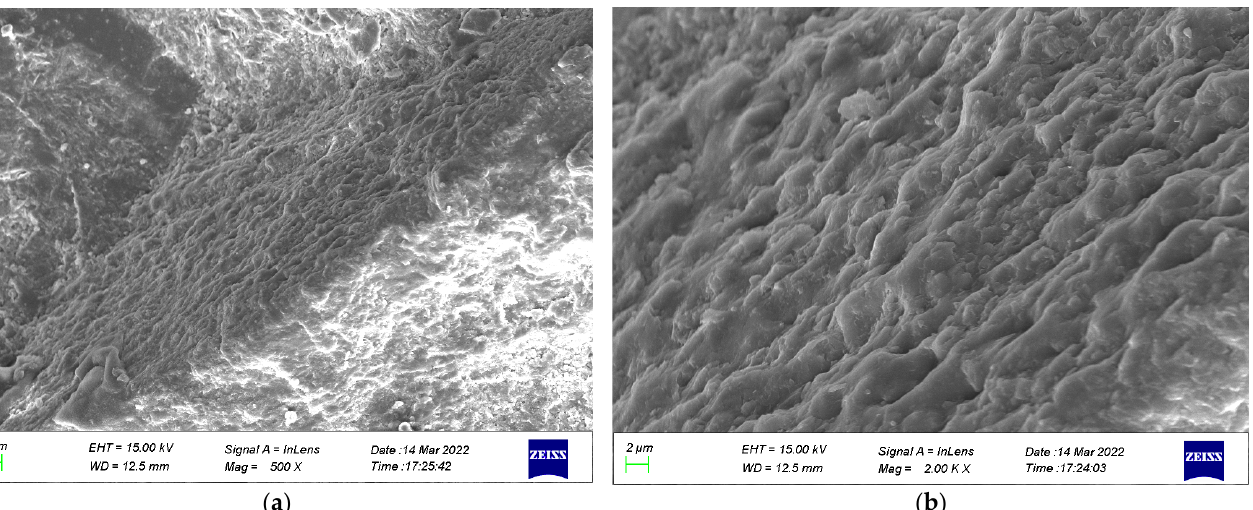
( b ) Figure 17. Micro-structure of aggregate, WER content 5%: ( a ) 500×; ( b ) 2000×. ( a ) ( b ) Figure 18. Micro-structure of aggregate, WER content 10%: ( a ) 500×; ( b ) 2000×.